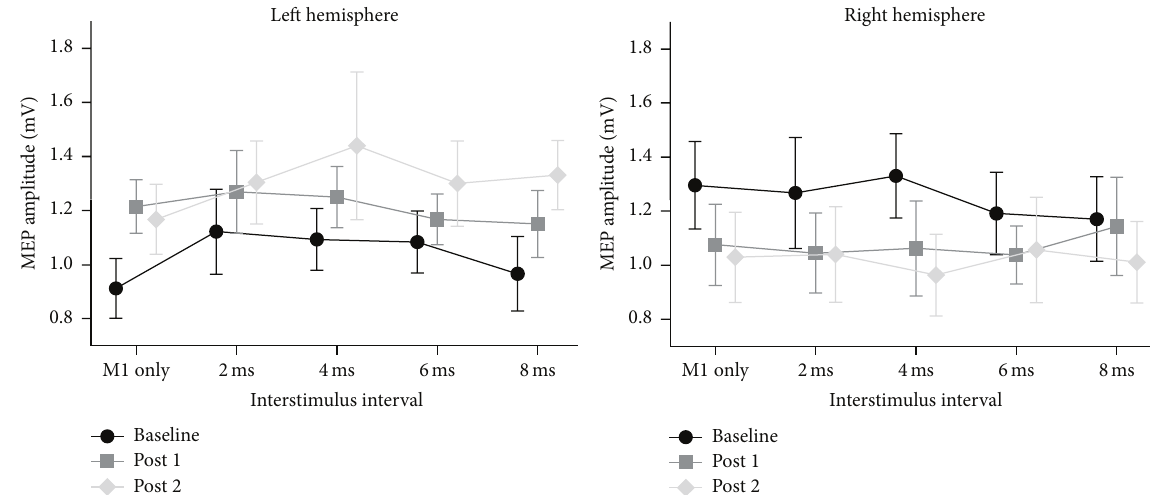
Figure 3: Raw MEP amplitudes shown separately for the five different stimulation conditions (M1-only and 4 PPC-M1 ISIs) at baseline, post 1, and post 2 for each stimulated hemisphere. MEP amplitude ( 𝑦 -axis) is represented in millivolts (mV) and error bars represent standard error of the mean